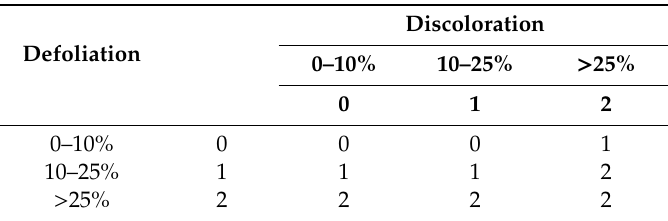
Table 1. Damage scores by combining defoliation and discoloration scores (modified according to Lakatos et al.